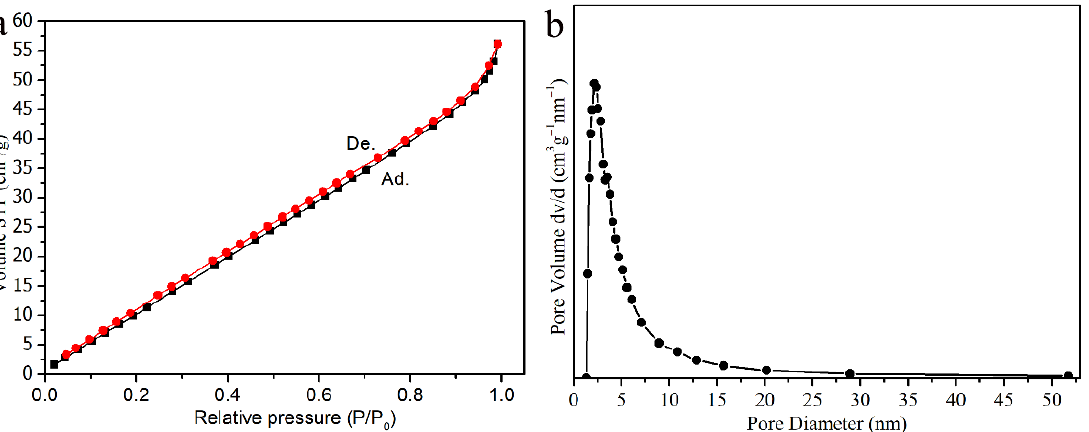
Figure 6. Nitrogen adsorption–desorption isothermal curve ( a ) and mesopore distribution ( b ) of CF/SrTiO 3 /CdS.